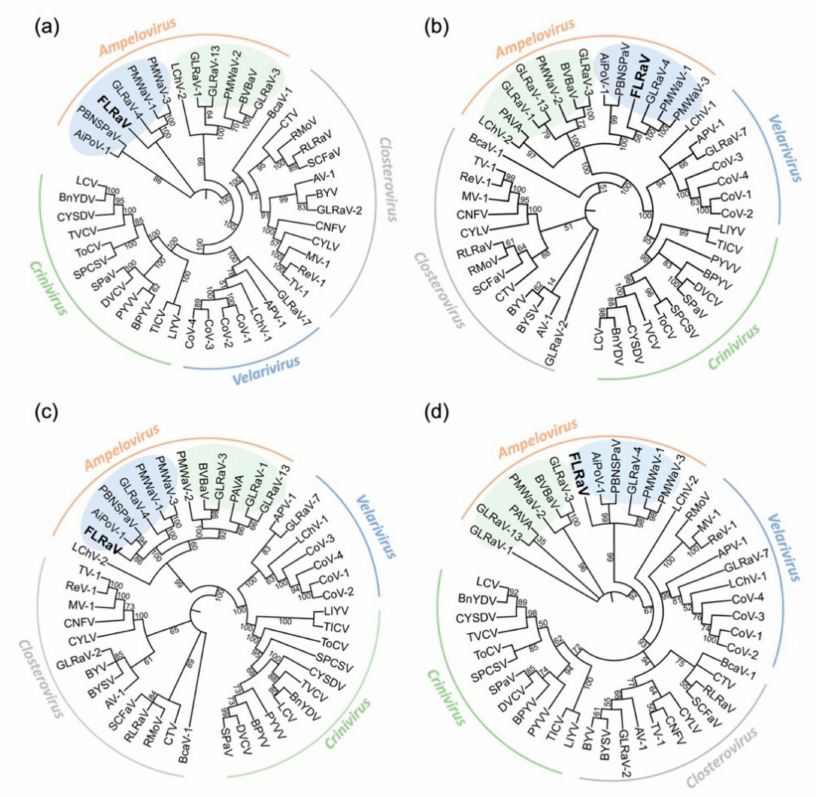
Figure 3. Phylogenetic trees constructed using the amino acid sequences of ORF1a ( a ), RdRp ( b ), HSP70h ( c ), and CP ( d ) of members in the family Closteroviridae . Bootstrap values (%) for 1000 replicates are indicated. Virus names are shown in Table S2. The light green and light blue ovals represent subgroups I and II of the Ampelovirus , respectively.